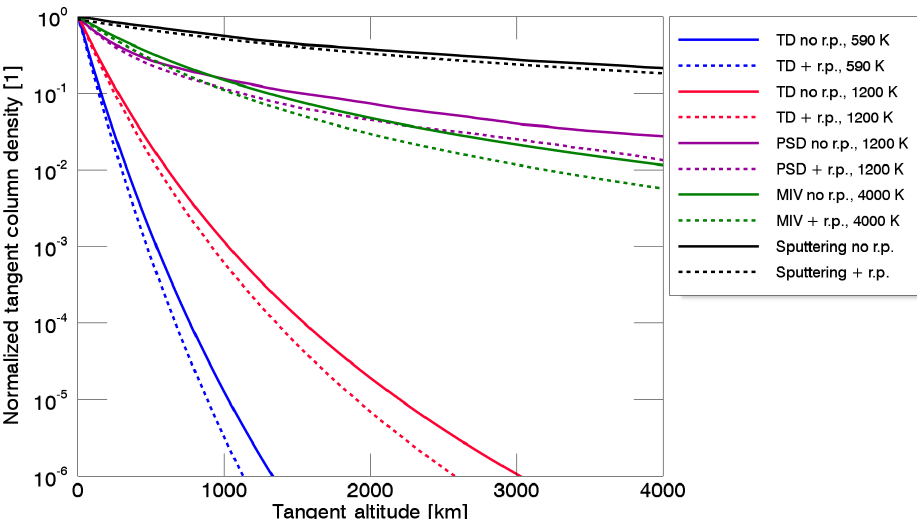
Figure 3. Column density profiles as a function of tangent altitude for Na where the column density at the surface is normalized to 1 and for the different release mechanisms: TD, PSD, MIV, and SP with and without radiation pressure (r.p.) centered at subsolar point and for different surface temperature values. The simulation was done with an ensemble of 10 6 particles and Mercury at TAA = 0202 ◦ and R orb = 0 . 458au.